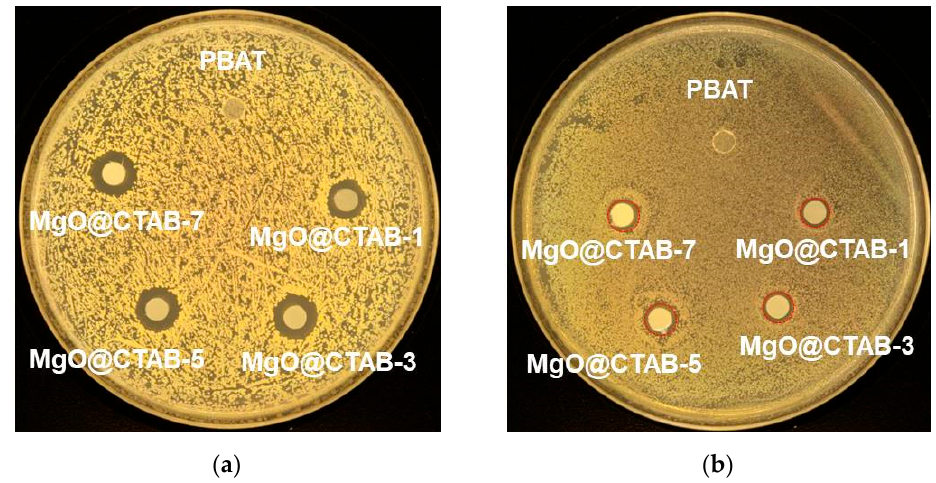
Figure 9. Photographs of antimicrobial test results of PBAT and its nanocomposite against ( a ) S . aureus , ( b ) E . coli . Table 4. Antimicrobial activity of PBAT nanocomposite films against S. aureus and E. coli. Sample